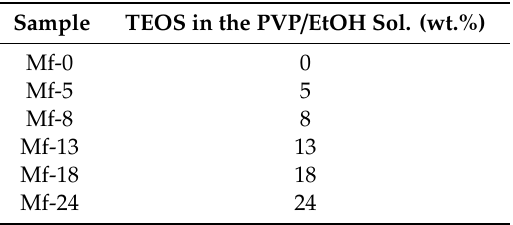
Table 1. Precursor solutions for